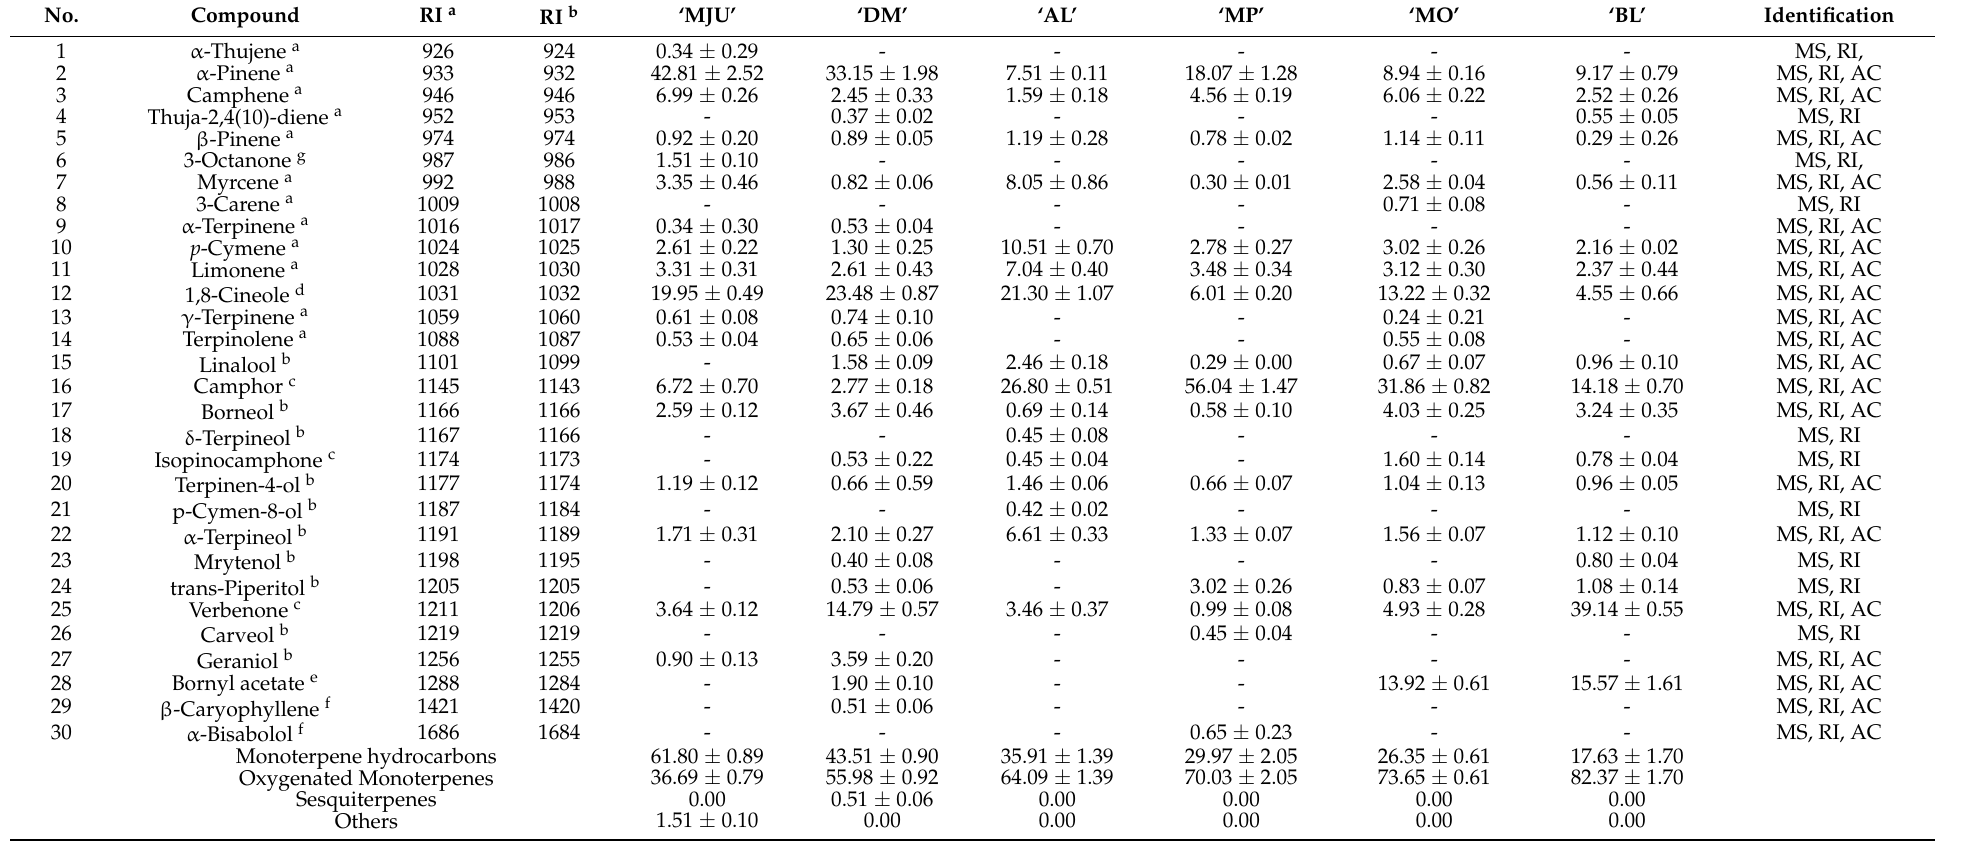
Table 1. The chemical composition identified of R. officinalis essential oils from six